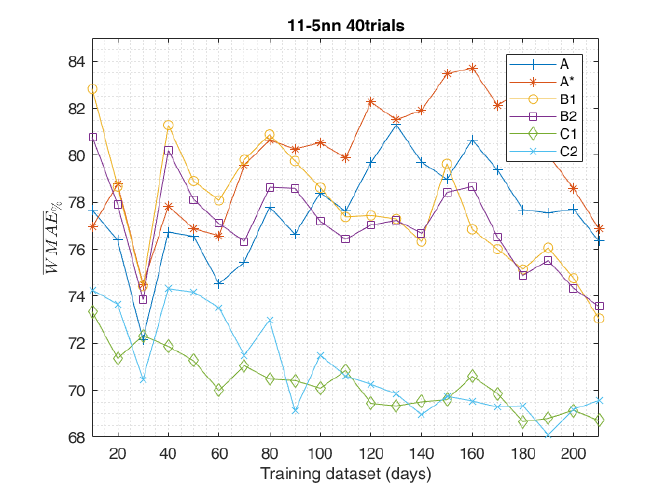
Figure 17. WMAE % as a function of the dataset